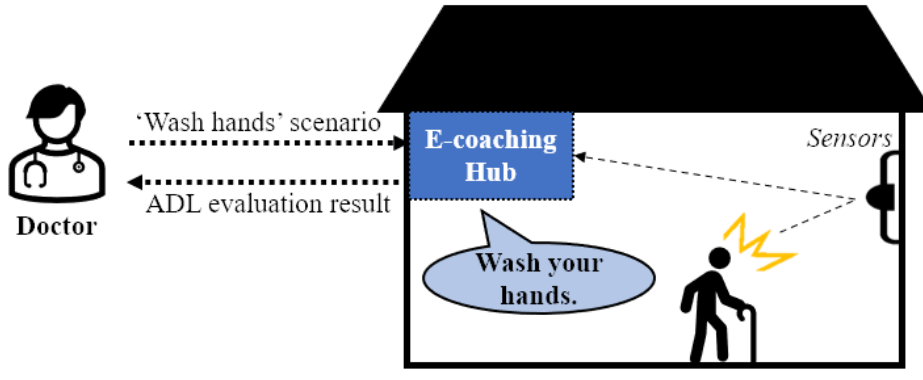
Figure 1. Remote e-coaching framework between a doctor at a hospital and a patient at home.